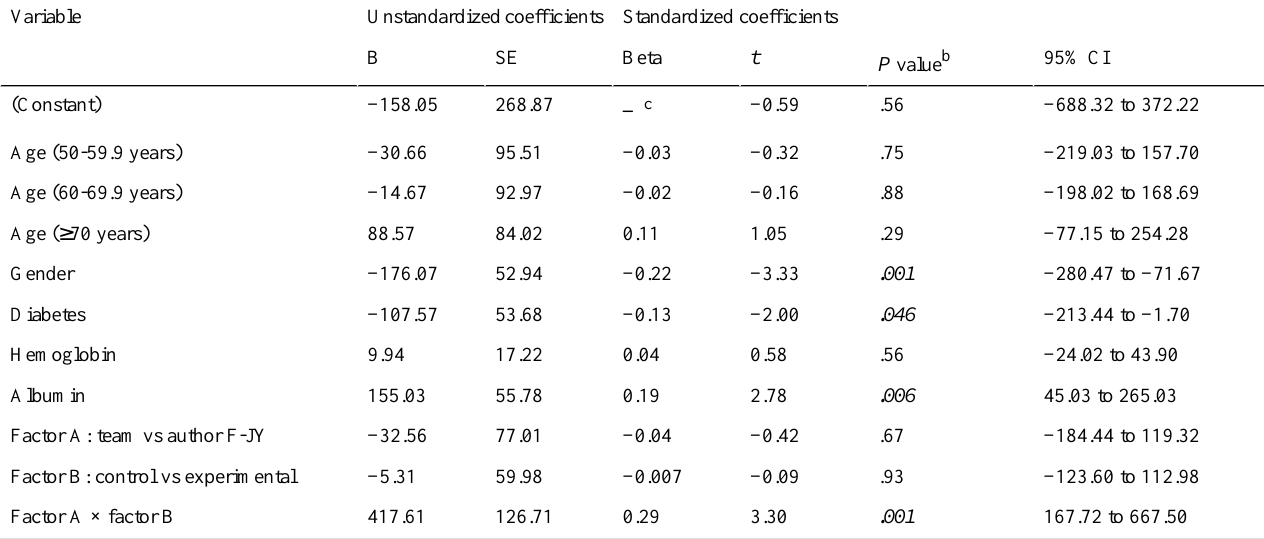
Table 6. Associations between time to dialysis and care model using difference in differences compared with the reference group (age <50 years) a .